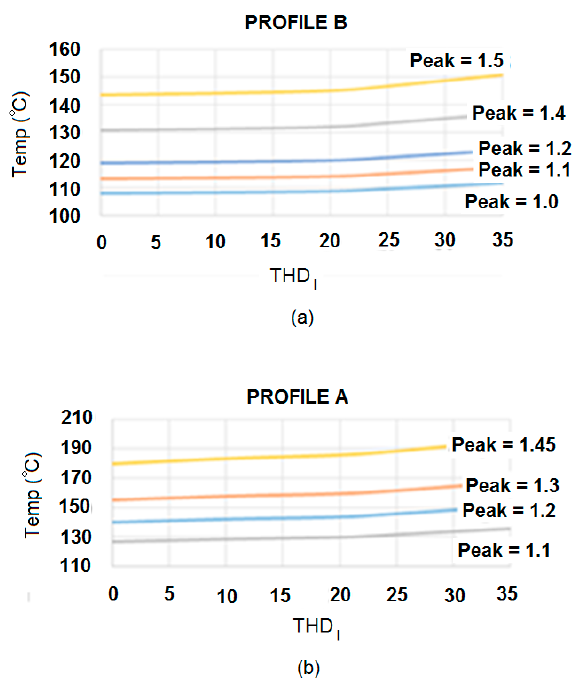
Figure 7. ( a ) Winding hottest spot temperatures induced by Profile B as a function of peak demand and harmonic current distortion. ( b ) Winding hottest spot temperatures induced by Profile A as a function of peak demand and harmonic current distortion.